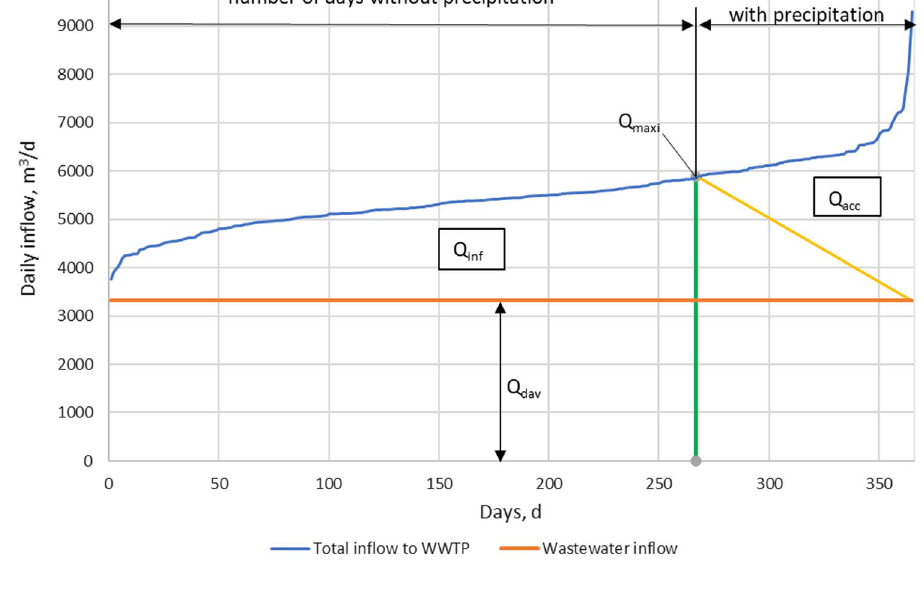
Fig. 5 Volumes of infiltration and accidental water inflow to WWTP in 2017 determined using the triangle